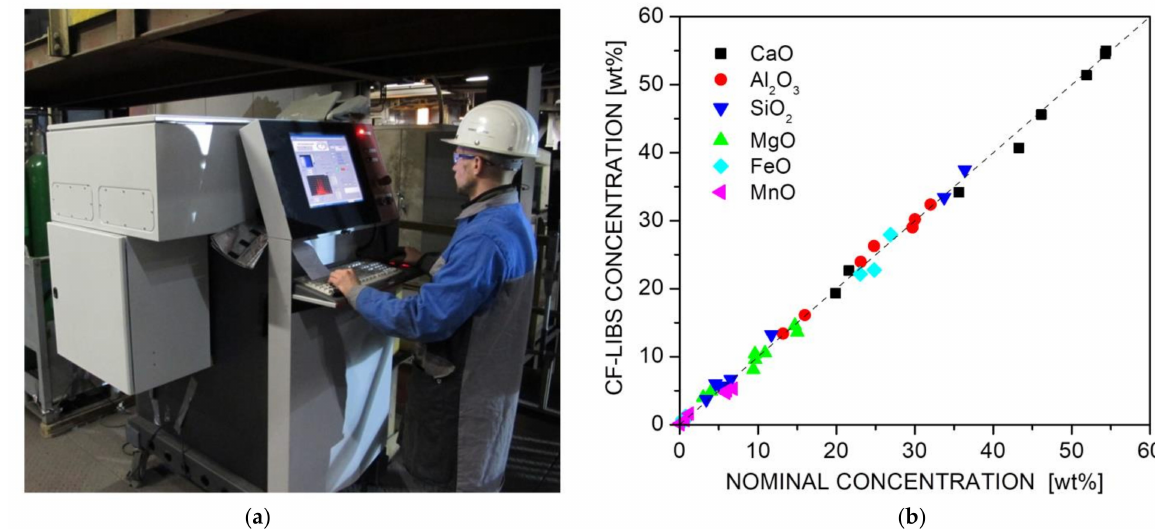
Figure 18. LIBS in-line measurement of solid steel slag in secondary metallurgy at voestalpine steel plant. ( a ) Photograph of the installed LIBS system. ( b ) Concentration of major oxides obtained by calibration-free (CF) analysis vs. nominal concentration (dashed line: ideal match). Adapted from